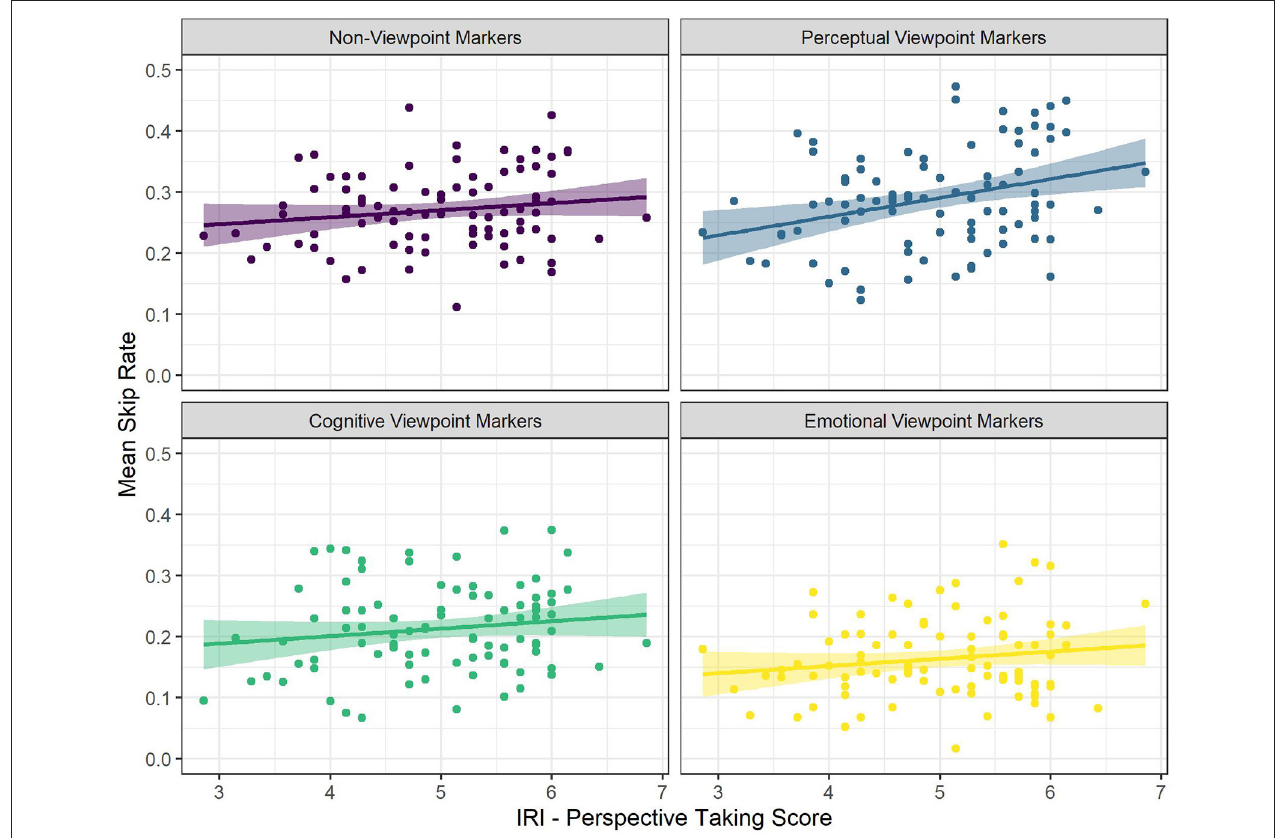
FIGURE 1 | The Relationships Between Mean Skip Rate and IRI Perspective Taking Score for the Different Categories of Viewpoint Markers. Each Dot Represents a